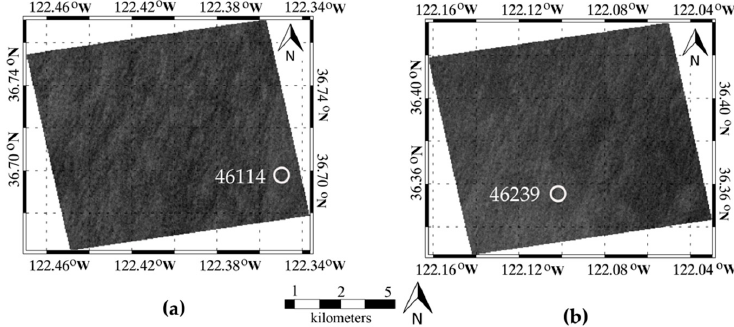
Figure 2. The quick-look image of sub-scene, which covers the location of the buoys ( a ) ID: 46114; and ( b ) ID: 46239.